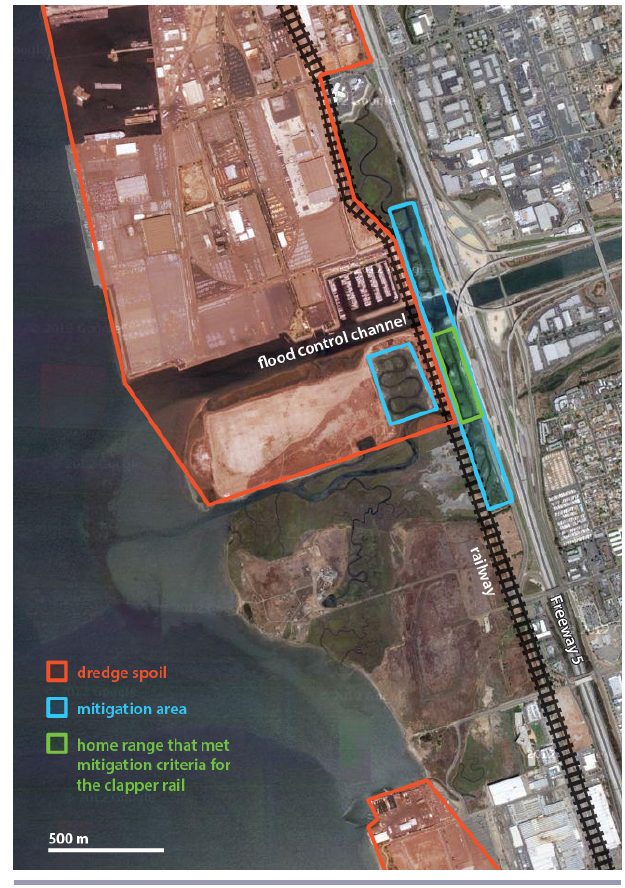
Fig. 4. Aerial photo of Sweetwater Marsh National Wildlife Refuge, surrounded by dredge spoils, abandoned